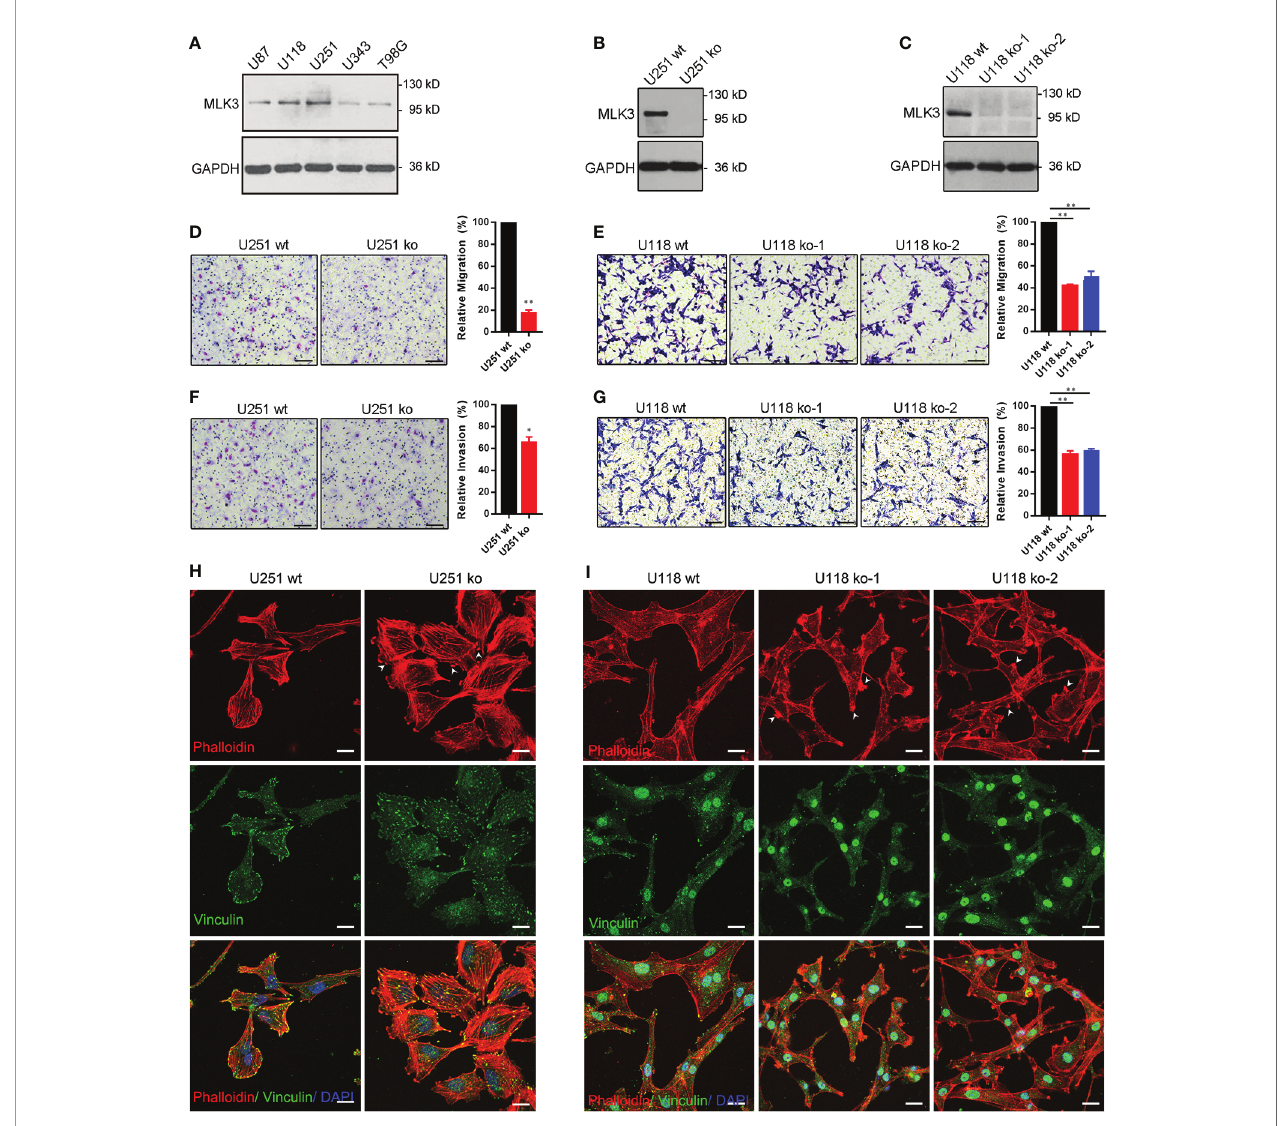
FIGURE 3 | MLK3 de fi ciency attenuates glioblastoma multiforme (GBM) cell migration and invasion and disrupts actin cytoskeleton rearrangement. (A) MLK3 proteins are overexpressed in highly migrating GBM cells. Cells were treated with serum-free DMEM for 48 h. Immunoblot analysis of MLK3 levels in several GBM cell lines. GAPDH was used as a loading control. (B, C) Immunoblot assay of the MAP3K11 gene knockout in U251 (B) and U118 (C) cells. GAPDH was used as a loading control. (D – G) Transwell assay of GBM cell migration and invasion in MAP3K11 gene knockout U251 (D, F) and U118 (E, G) cells. Two-tailed Student ’ s t -test. Scale bars, 100 m m; n = 3; ** P < 0.01. (H, I) The loss of MLK3 disrupts actin cytoskeleton rearrangement. The results shown are representative of at least three independent cultures. Phalloidin was used to label F-actin (red), anti-vinculin antibody was used to stain focal adhesion structure (green), and DAPI was used to stain nuclei (blue). White arrows indicate the actin based “ mass-like structures. ” Scale bars, 20 m